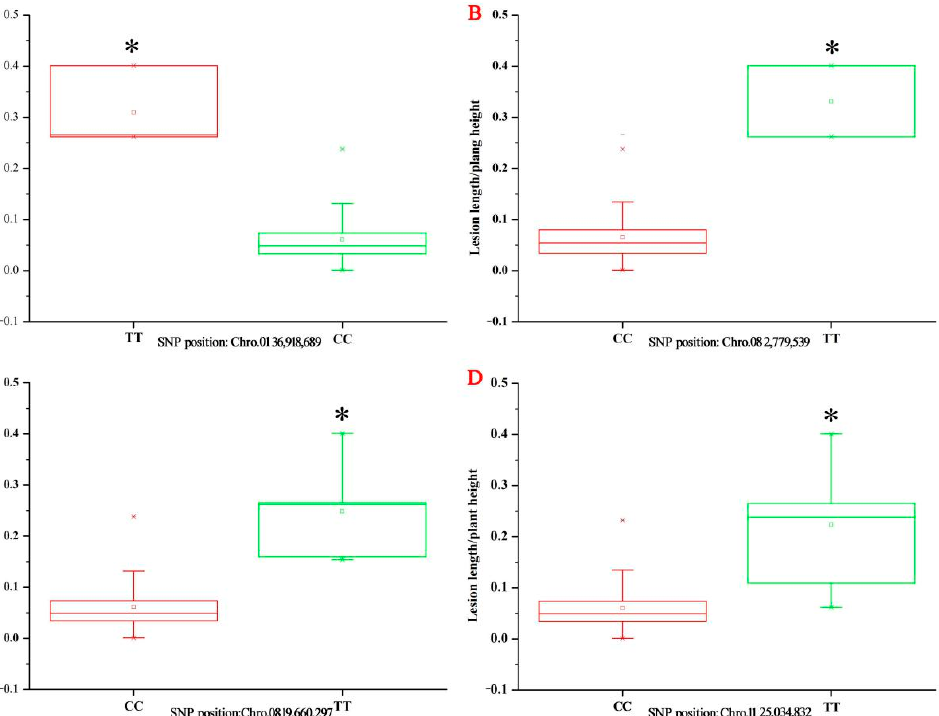
Figure 4. Effect analysis of allelic variations of top four significant SNPs on ShB resistance (lesion length/plant height) in 2016. ( A ) SNP position on Chro. 01 36,918,689. ( B ) SNP position on Chro. 08 2,779,539. ( C ) SNP position on Chro. 08 19,660,297. ( D ) SNP position on Chro. 11 25,034,832. Lesion